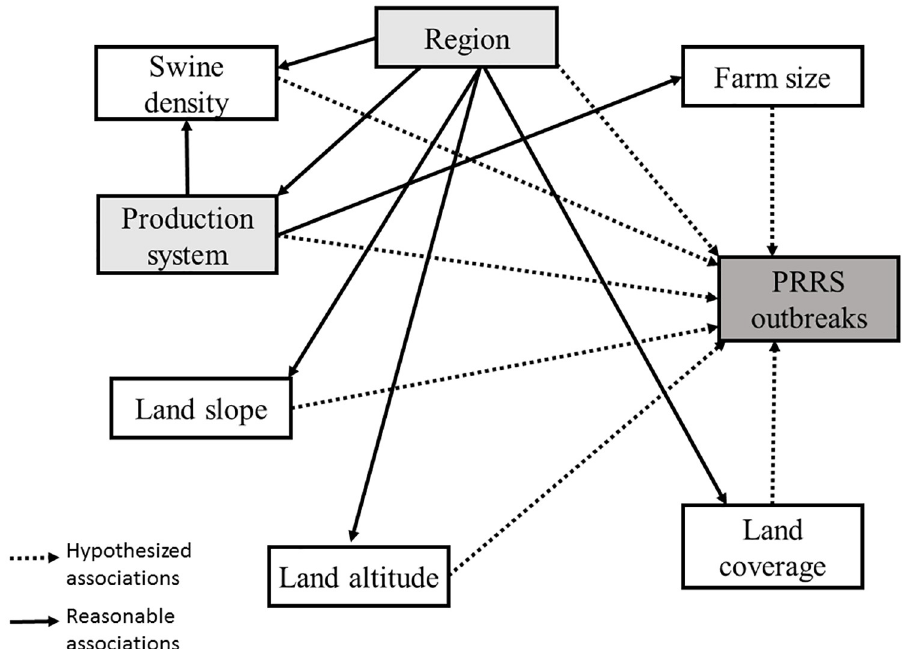
Fig 4. Causal diagram showing the hypothesized and plausible associations between the outcome of interest and investigated exploratory variables.